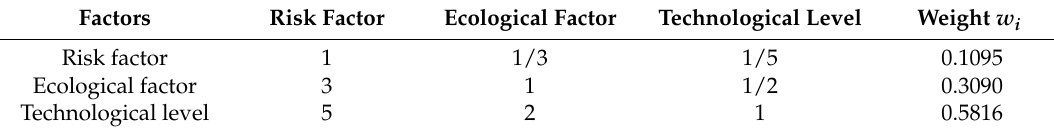
Table 1. Expert judgments and weights.